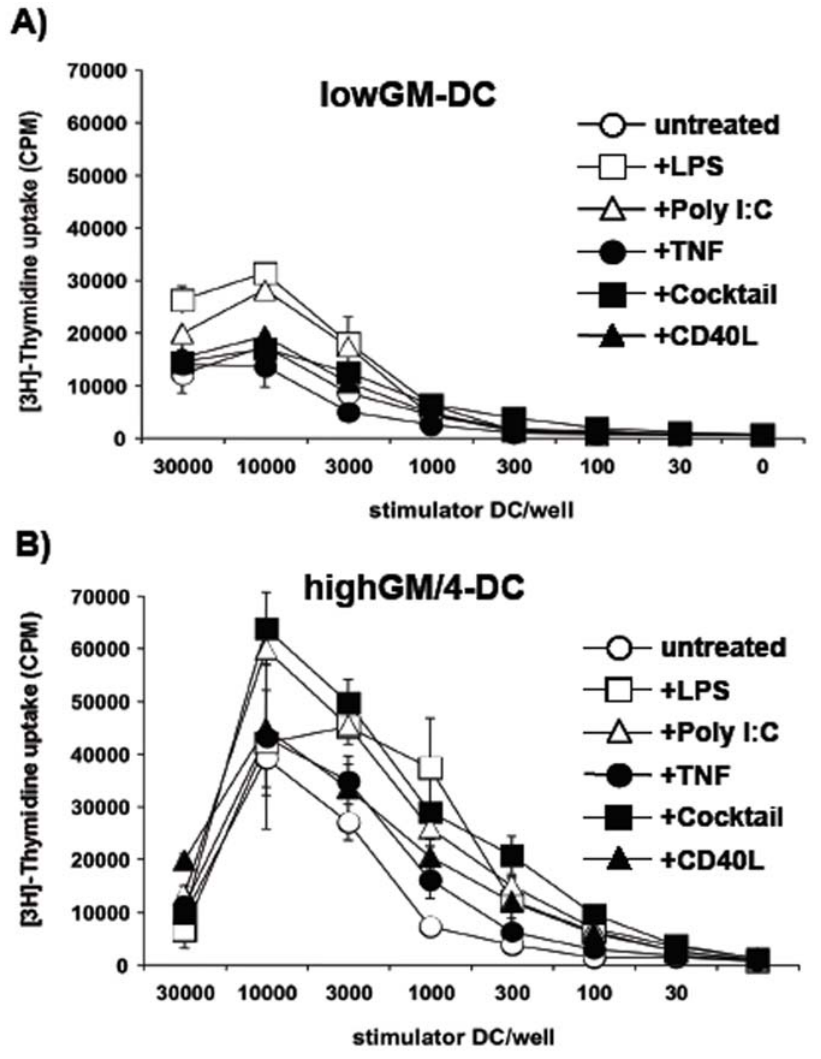
Figure 2. LowGM-DC remain functionally immature after maturation. DC were generated under low-GM (A) and standard highGM plus IL-4 conditions (B) for 6 days, stimulated with the indicated reagents or a ‘‘cocktail’’ consisting of TNF, IL-1 b , IL-6 and PGE 2 for 24 h and then added at titrated numbers to allogeneic T cells, as represented by non-adherent fraction of PBMC of an allogeneic donor. After 3 days [ 3 H]-thymidine was added overnight to measure proliferation. The data from one experiment shown are representative of 3 independent experiments. Values represent the mean 6 standard deviation error bars of triplicate cultures from one experiment.